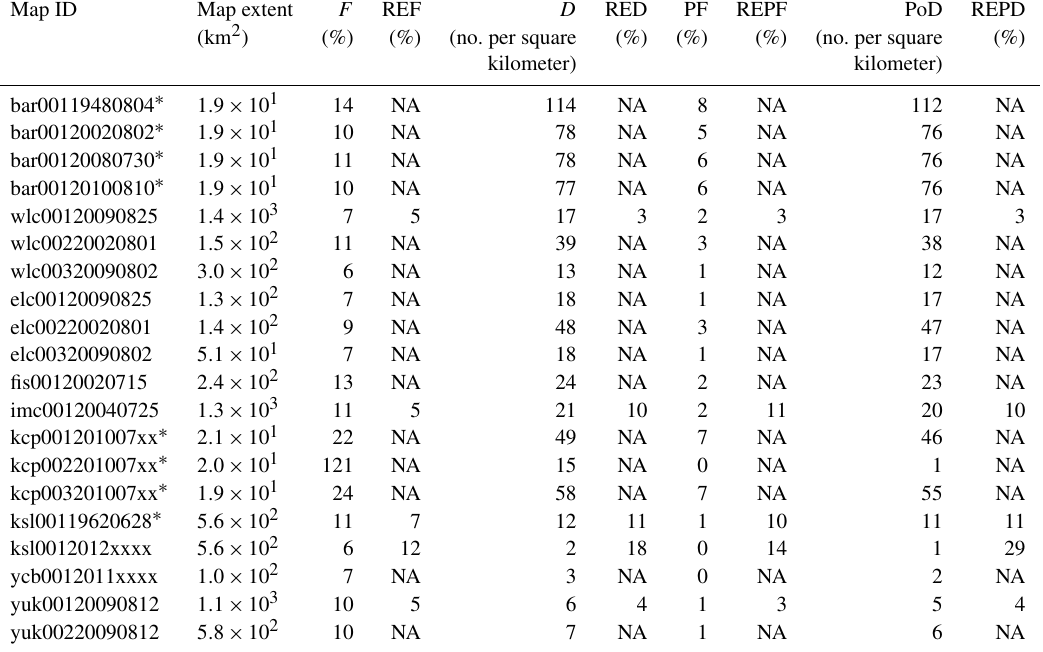
Table E1. Areal fraction and density per waterbody map in Alaska. Map IDs with an asterisk were not used for extrapolation. F : areal fraction of waterbodies from 1 . × 10 2 to 1 . 0 × 10 6 m 2 in size; REF: relative error of fraction for map subsets of 10km × 10km; D : waterbody density per square kilometer; RED: relative error of density; PF: pond areal fraction for waterbodies from 1 . 0 × 10 2 m 2 to smaller than